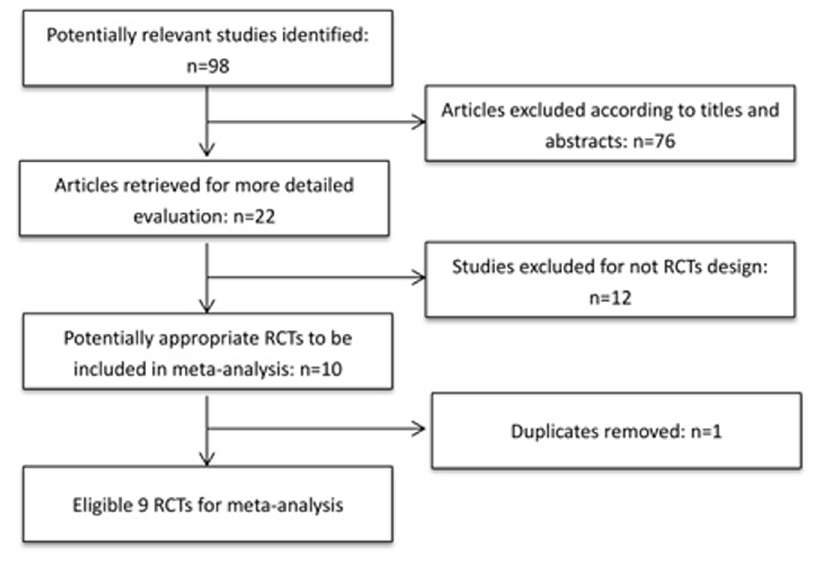
Figure 1. Flow chart of literature search and study selection.